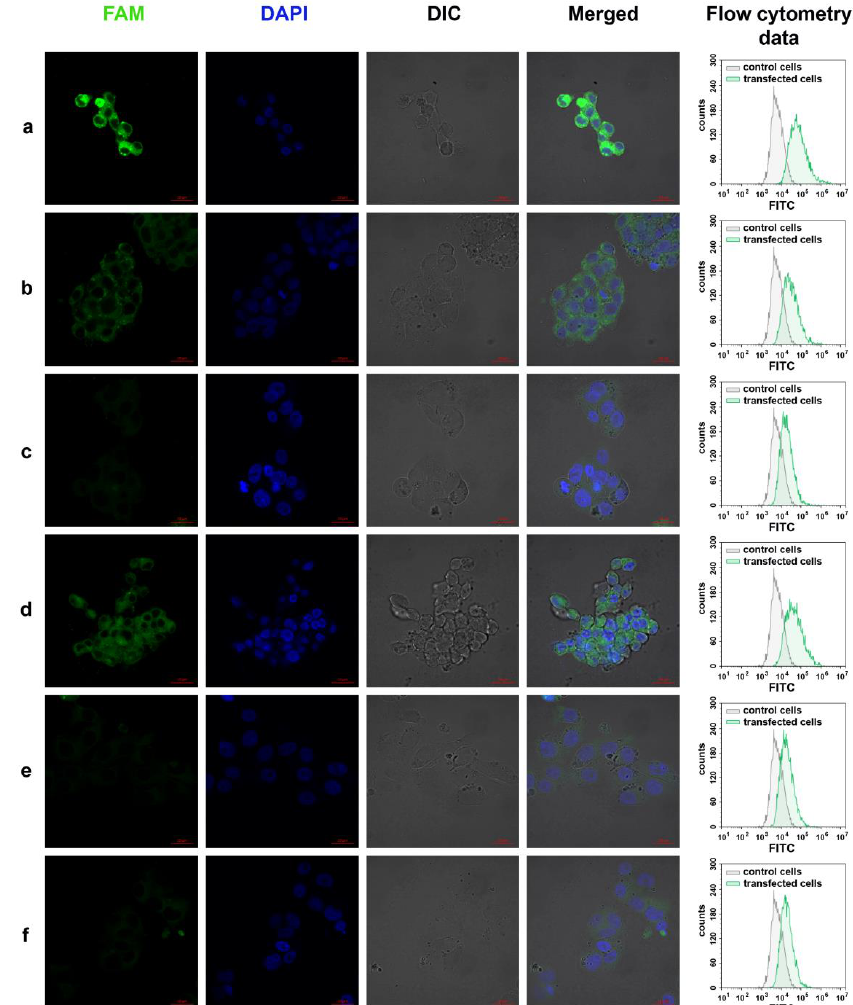
Figure 8. Qualitative (confocal fluorescent microscopy imaging) and quantitative (flow cytometry data) characterizations of HepG2 cells treated with 5 µM fluorescently labeled either FAM-D-17 PG (a-c) DOC or D-17 PG /FAM-17′ ( d – f ) duplex in DMEM medium ( a , d ); in DMEM supplemented